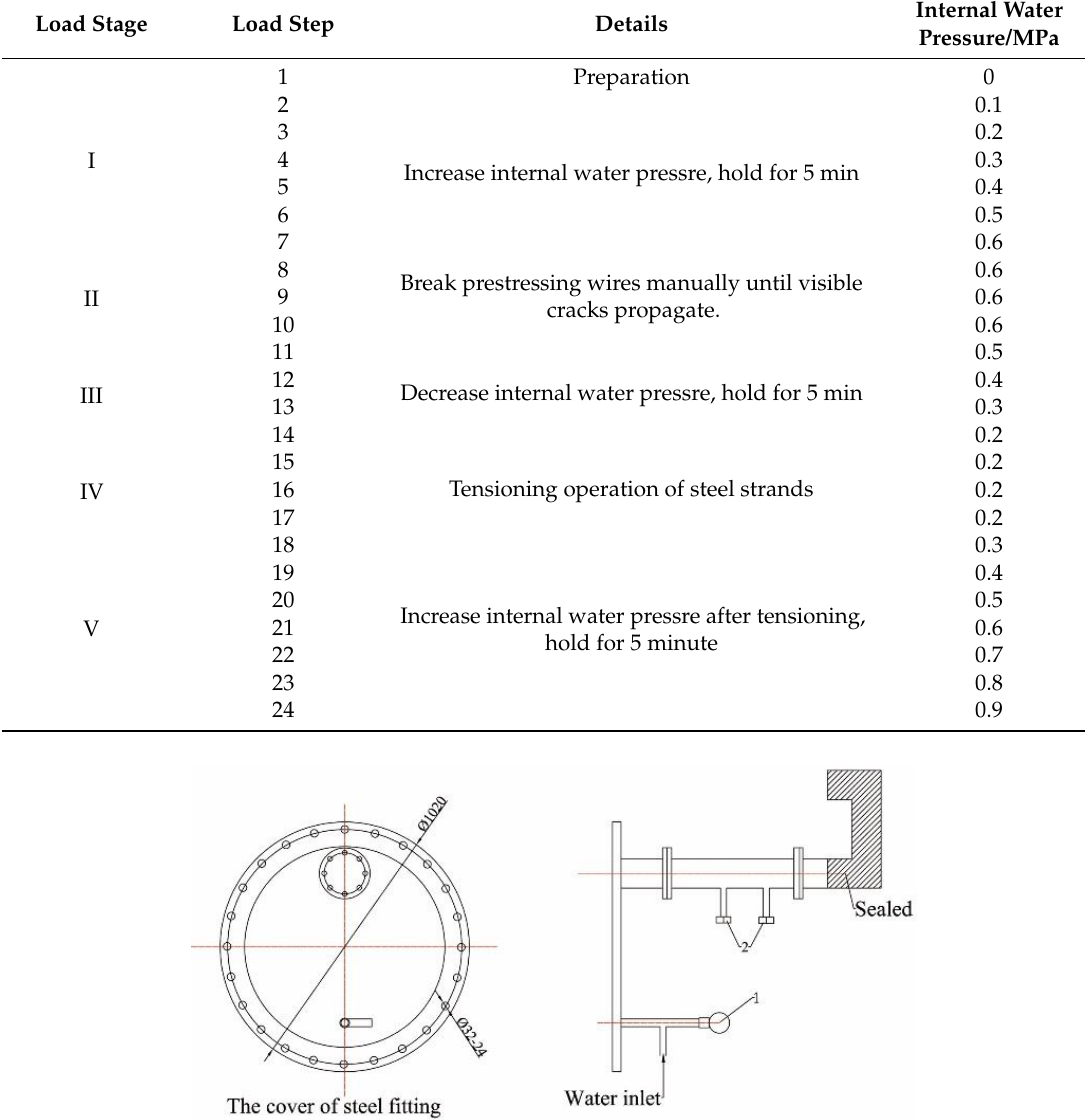
Figure 7. The location of pressure monitors: 1—Pressure gauge; 2—Pressure transmitter.